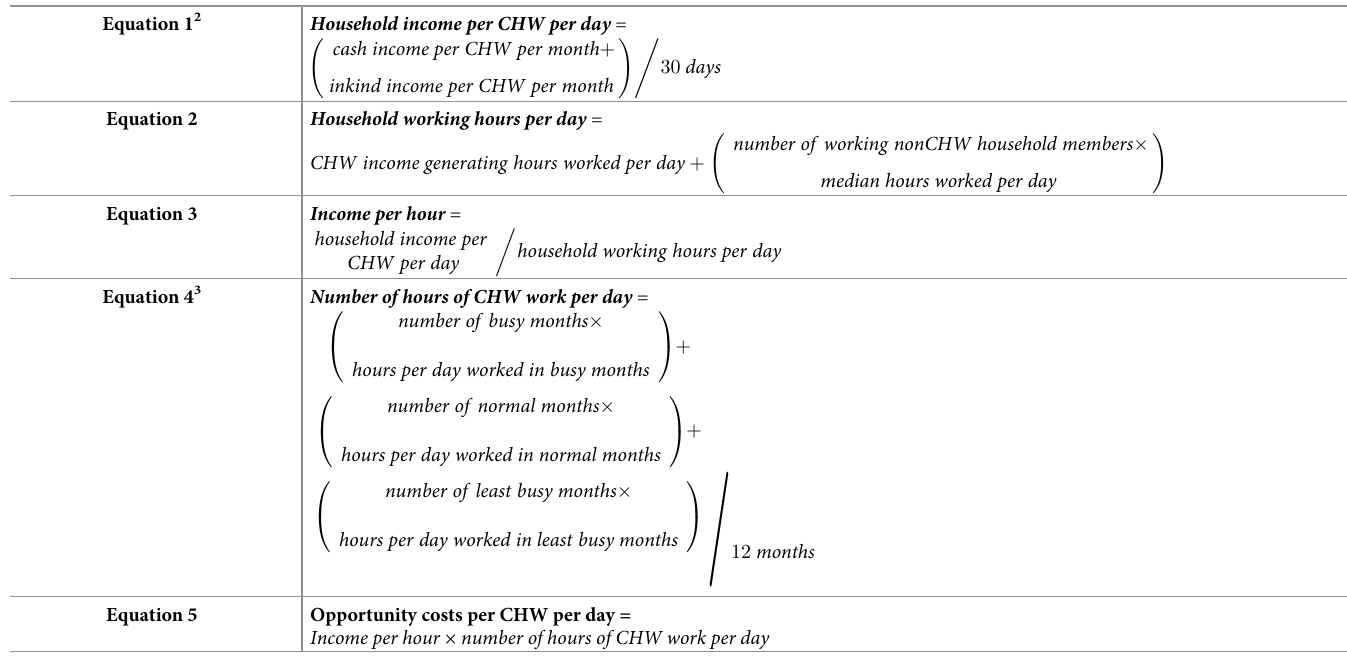
Table 1. Equations used to calculate Community Health Worker (CHW) opportunity costs 1 in